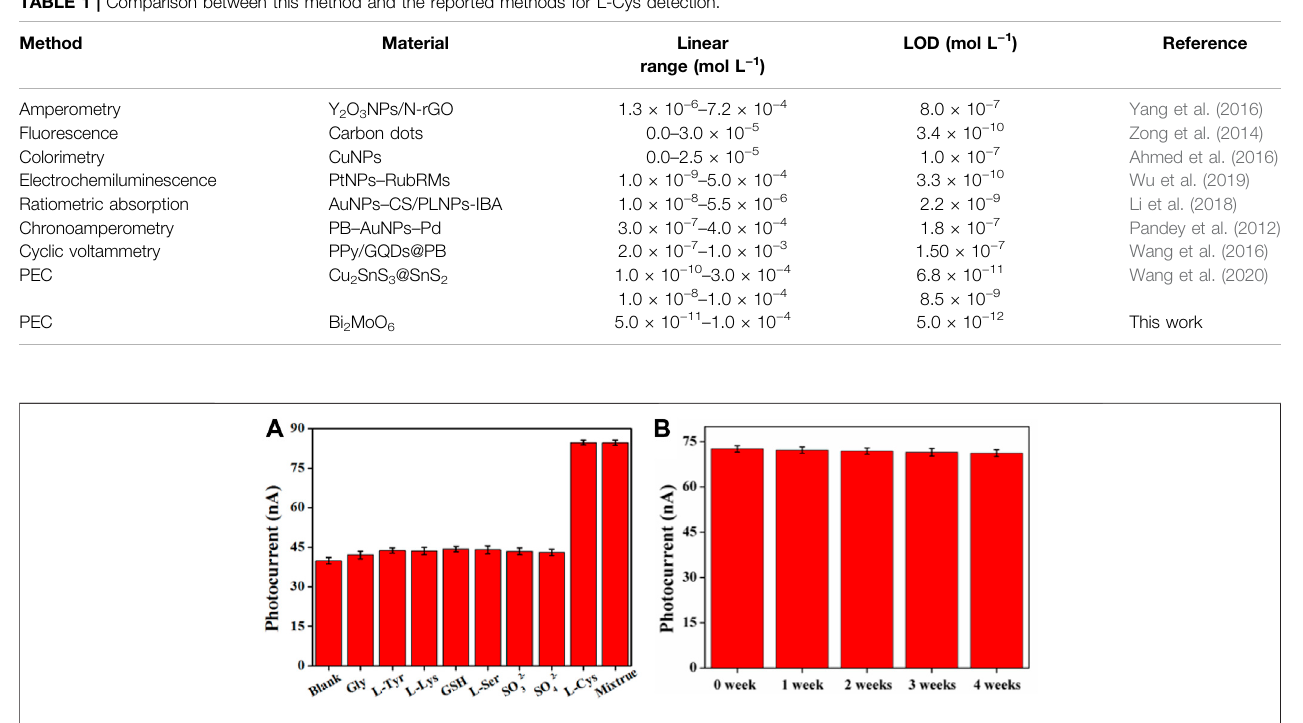
TABLE 1 | Comparison between this method and the reported methods for L-Cys detection.